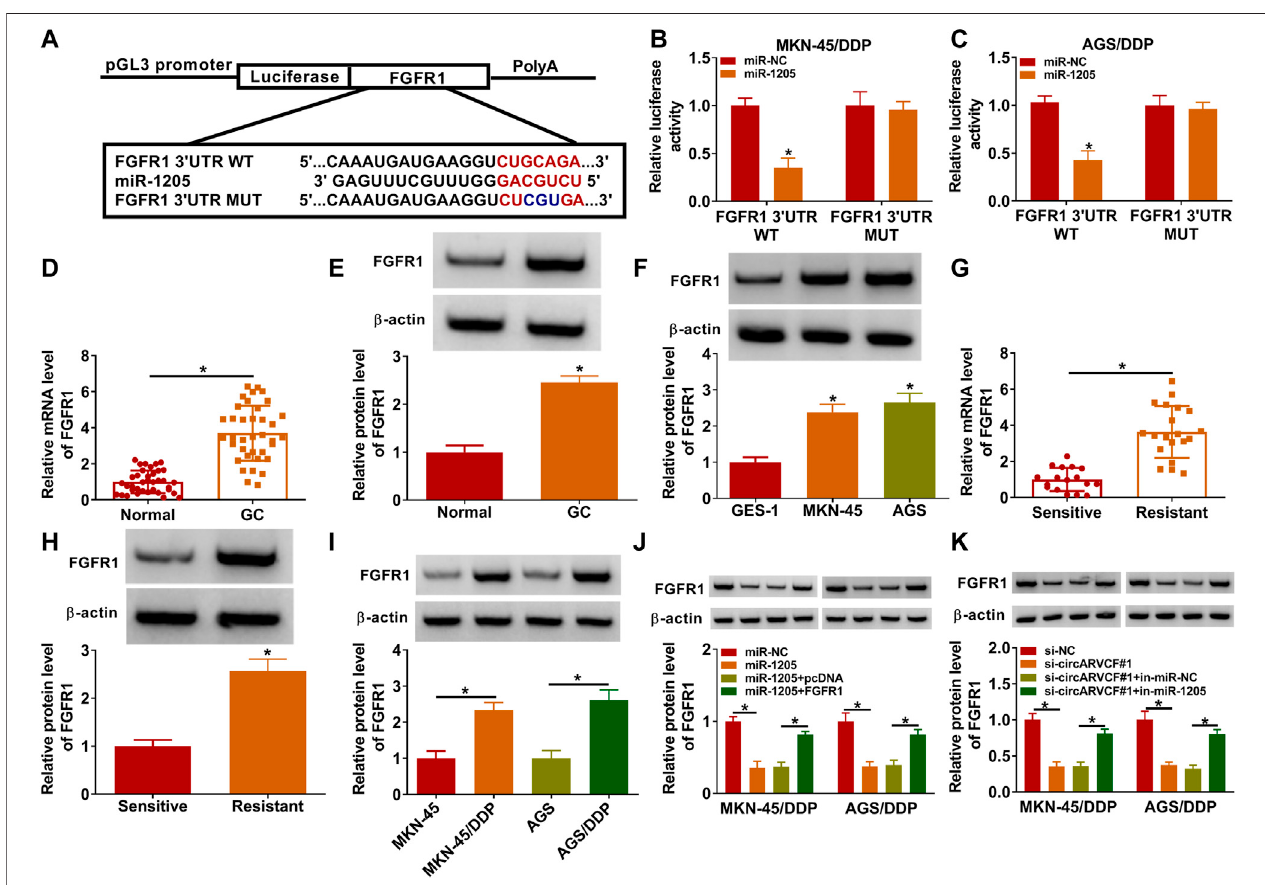
FIGURE 5 | CircARVCF regulated FGFR1 expression by targeting miR-1205. (A) The complementary sequences between FGFR1 and miR-1205 were exhibited. (B,C) The relationship between FGFR1 and miR-1205 was analyzed by dual-luciferase reporter assay. (D,E) The mRNA and protein levels of FGFR1 in GC tissues and normal tissues were measured by qRT-PCR or western blot assay. (F) The protein level of FGFR1 in GES-1, MKN-45 and AGS cells was measured via western blot assay. (G,H) The mRNA and protein levels of FGFR1 in DDP-resistant and DDP-sensitive GC tissues were quanti fi ed by qRT-PCR or western blot. (I) The protein levelofFGFR1inMKN-45,MKN-45/DDP,AGSandAGS/DDPcellswasmeasuredviawesternblotassay. (J) TheproteinlevelofFGFR1inMKN-45/DDPandAGS/DDP cells transfected with miR-NC, miR-1205, miR-1205 + pcDNA or miR-1205 + FGFR1 was measured via western blot assay. (K) The protein level of FGFR1 in MKN-45/ DDP and AGS/DDP cells transfected with si-NC, si-circARVCF#1, si-circARVCF#1+in-miR-NC or si-circARVCF#1+in-miE-1205 was measured through western blot assay. * p <